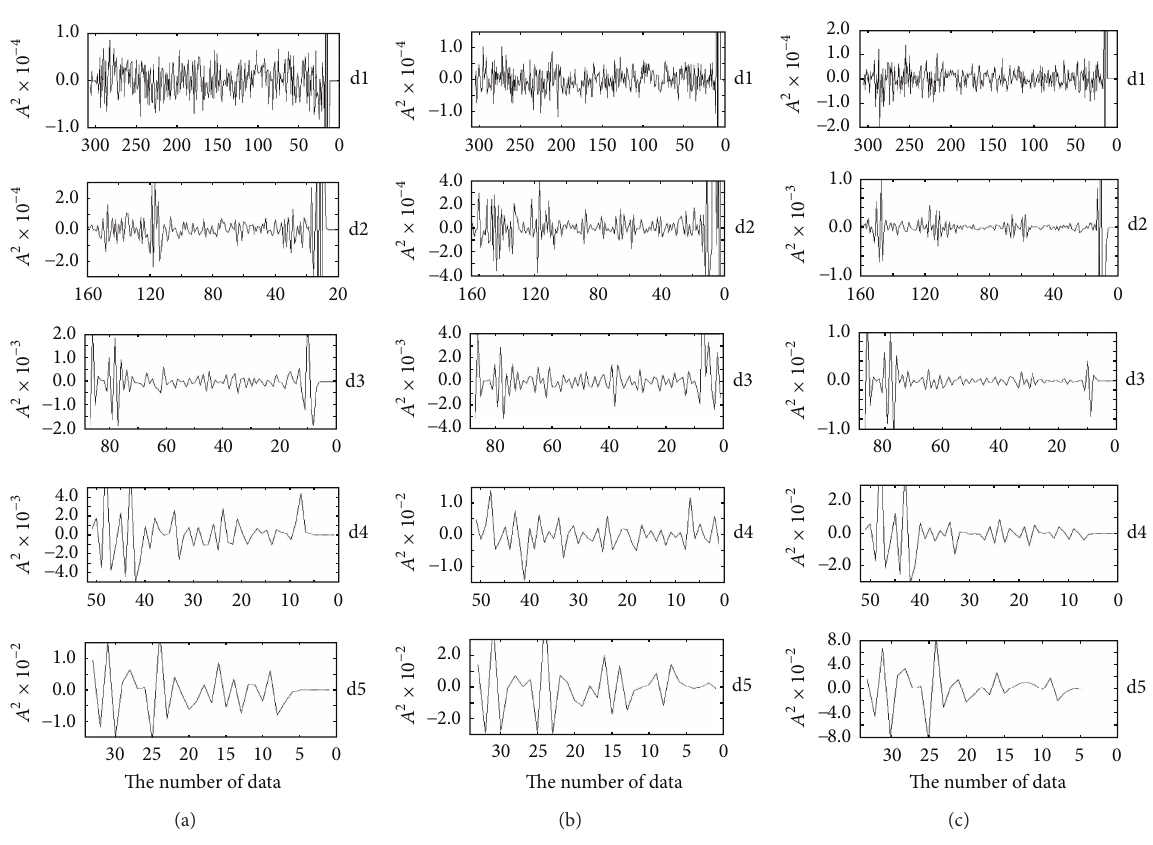
Figure 5: Coefficients of five scales of (a) cuscutae semen; (b) Japanese dodder; and (c) sinapis semen in DWT